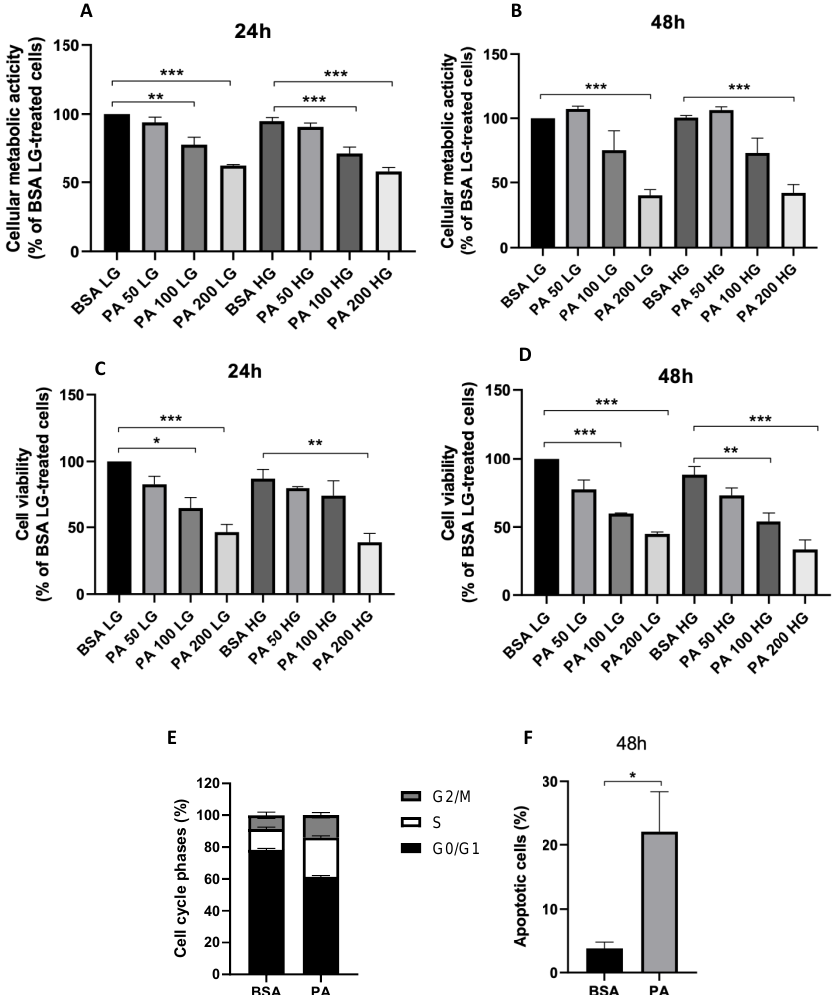
Figure 3. Palmitic acid (PA)-induced cytotoxicity. ARPE-19 cell metabolic activity ( A , B ) and viabil- ity ( C , D ) assessed after 24 ( A , C ) and 48 h ( B , D ) incubation with low glucose (LG, 5 mM glucose) or high glucose concentration (HG, 13 mM glucose) in the presence or absence of 50, 100 and 200 µM PA. Cell cycle ( E ) and apoptosis ( F ) of ARPE-19 cells in response to 48 h treatment with bovine serum albumin (BSA) or 200 µM PA. Results are reported as mean ± SEM of at least three independ- ent experiments. * p < 0.05, ** p < 0.01, *** p < 0.001.